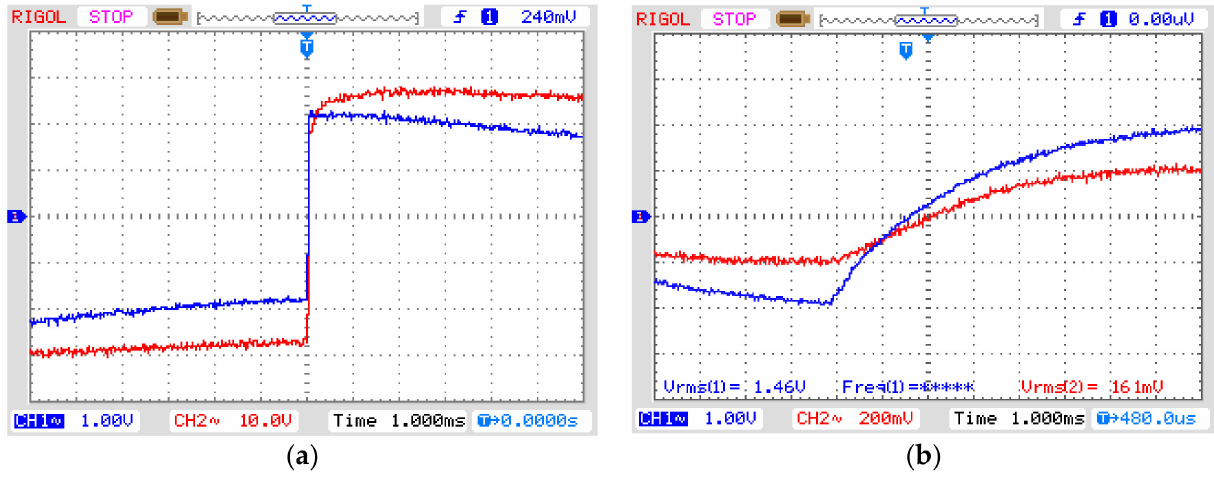
Figure 15. Step response. ( a ) CH1: input signal from signal generator to amplifier, CH2: amplifier output voltage. Vertical axis: 1 V/div (CH1) and 10 V/div (CH2). Horizontal axis: 1 ms/div; ( b ) CH1: OVT input voltage, CH2: OVT output voltage. Vertical axis: 1 V/div (CH1) and 200 mV/div (CH2). Horizontal axis: 1